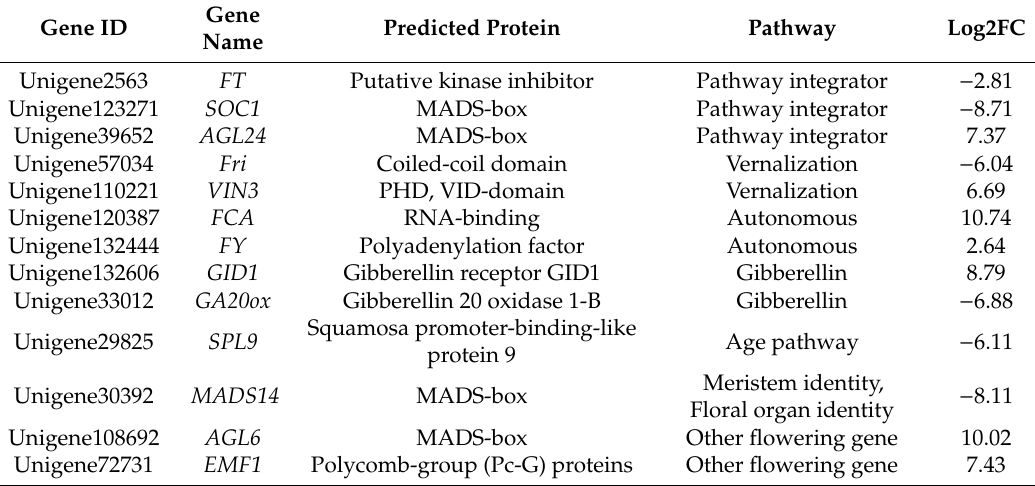
Table 2. The DEGs of major floral pathway loci and genes between vegetative leaves and flowering leaves (L0 vs